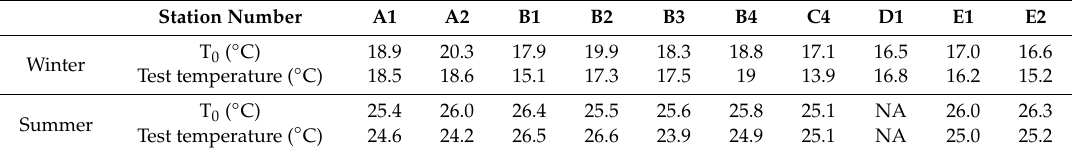
Table 6. Thermal neutral temperature of high-speed railway